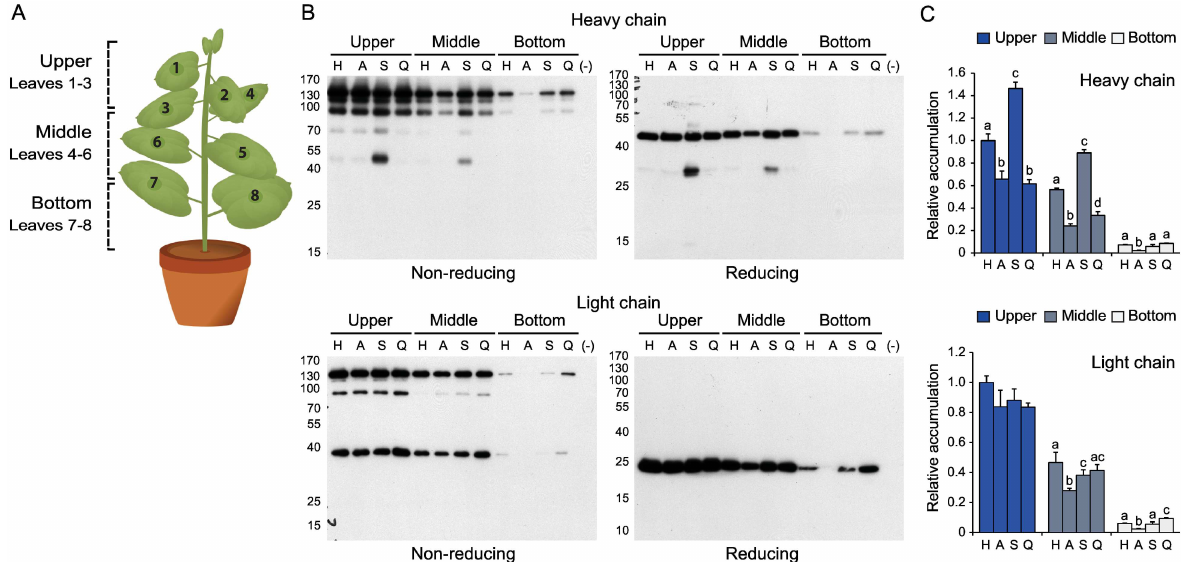
Fig 2. H10 antibody profiles in upper, middle and bottom leaves of N . benthamiana expressing the antibody alone or in combination with an accessory protease inhibitor. A: Schematic representation of a typical 42 day-old N . benthamiana plant, with eight leaves arrangedin an alternate pattern along the main stem. The leaves were groupedin three categories based on their positionon the stem, from the apex down: the ’Upper’leaves corresponding to young growingleaves (Leaves 1, 2 and 3), the ’Middle’leaves corresponding to fully expanded mature leaves (Leaves4, 5 and 6) and the ’Bottom’ leaves corresponding to older–including senescent– leaves (Leaves7 and 8). B: Representative immunoblots for full size H10 expression. Leaf protein extracts were submitted to SDS-PAGE in reducing or non-reducing conditions, and then electro-transferred onto nitrocellulosemembranes for immunodetection. The membranes were probedwith an anti-human γ chain HRP-conjugatedantibodyto detect the heavy chain or with an anti-human λ chain HRP-conjugatedantibodyto detect the light chain. The position of molecularmass markers is shown on the left (kDa). (–) stands for empty vector-transfected plants (negativecontrols). C: Quantitative ELISA for H10 heavy and light chains. The two chains were expressedalone(H) or together with α 1 -ACT (A), SlCYS8 (S) or Q47P (Q). Data are expressedcomparedto the H alone treatment in upper leaves (arbitrary value of 1.0). Each bar is the mean of three independent(biological) replicates ± SE . For each leaf morphological zone, bars with different letters are significantlydifferent (post- ANOVA Tukey’s test; P <